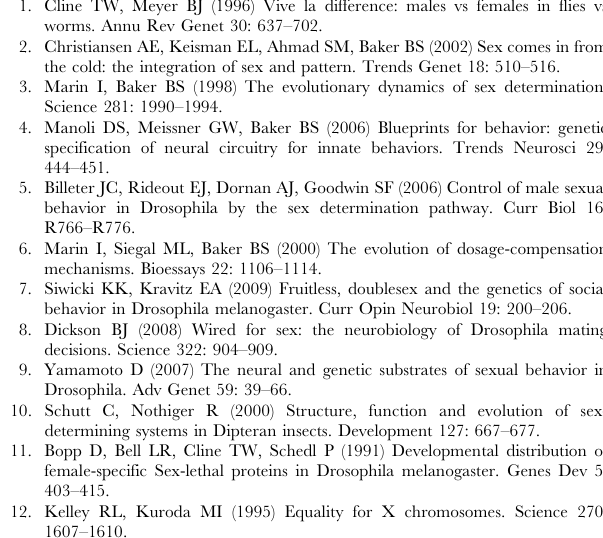
adult male. Single confocal section shown. (B) Expression of UAS- RedStinger nuclear DsRed reporter reveals patches of oenocytes around the abdominal spiracles (arrows) of an adult female. Lateral view of live, whole abdomen. Rows of abdominal muscle nuclei are also seen on the ventral abdomen (bracket). Anterior (A), posterior (P), dorsal (D), and ventral (V). Confocal Z projection. (Ci–ii) Expression of UAS-RedStinger nuclear DsRed reporter reveals patches of oenocytes under the segmental sternites (brackets) of an adult female. Ventral view of live, whole abdomen. Laterally oriented rows of abdominal muscle nuclei are seen. Large nuclei of a Malpighian tubule are also seen under the abdominal wall (arrows). Confocal Z-projection. (Ci) DsRed alone. (Cii) DsRed (red) merged with cuticle autofluorescence (blue). Found at: doi:10.1371/journal.pbio.1000365.s002 (2.38 MB TIF) Figure S3 dsx GAL4 is expressed in subsets of cells and tissues of adult digestive organs. Cross-sections and superficial views of various digestive organs from a 7-d-old adult female. DNA is stained with DAPI (blue in merge images). Confocal Z projections. (A) Expression of UAS-RedStinger nuclear DsRed reporter ( dsx , red in merge) is seen in a subset of epithelial tissues of the proventriculus (bracket), most prominently in the stomadaeal valve (arrow). Expression is also seen in crop epithelia (barbed arrow). Cross-section shown. (B) Expression of UAS-mCD8::GFP membrane-bound GFP reporter ( dsx , green in merge) in a low magnification, superficial view of the midgut. (C) Expression of UAS-mCD8::GFP membrane-bound GFP reporter (green) in a high magnification, superficial view of an anterior portion of the midgut. Large enterocytes (arrow) in this region express dsx GAL4 . (D) Expression of UAS-RedStinger nuclear DsRed reporter (red). (Di) Surface of crop epithelium (bracket) with dsx GAL4 expression in a subset of cells. (Dii) Expression is seen in the Malpighian tubules (arrow) but not the hindgut (bracket). Figure S4 dsx GAL4 is expressed in adult muscles. (A) Expression of UAS-RedStinger nuclear DsRed reporter (red) in large muscles of the thorax in a 7-d-old adult female. In the absence of dsx GAL4 ( 2 dsx GAL4 ), UAS-RedStinger is not expressed. In the presence of ( + dsx GAL4 ), DsRed (red) is seen in the rows of muscle nuclei. DNA stained with DAPI (blue).